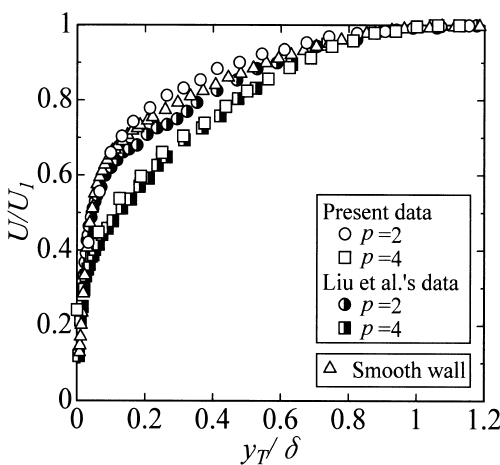
Figure 2 Streamwise mean velocity